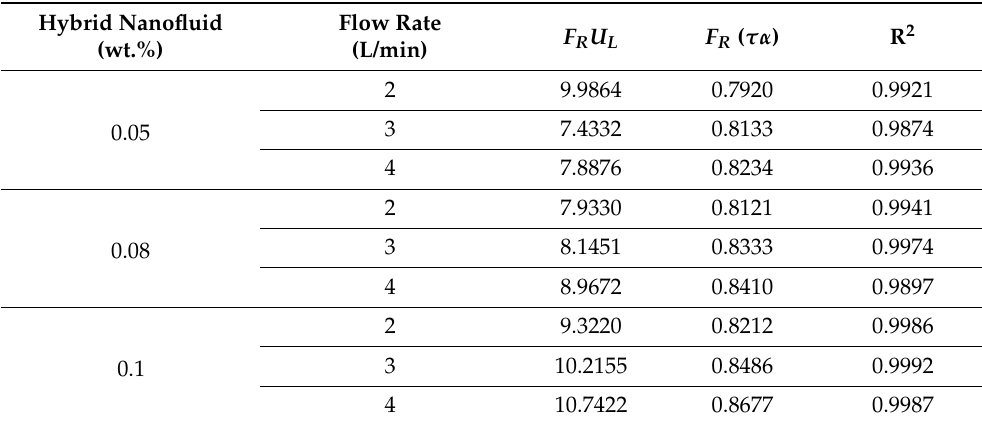
Table 5. Comparison of removed energy parameter and absorbed energy parameter for hy- brid nanofluids given various weight concentrations and different flow rates, together with their regression coefficients.